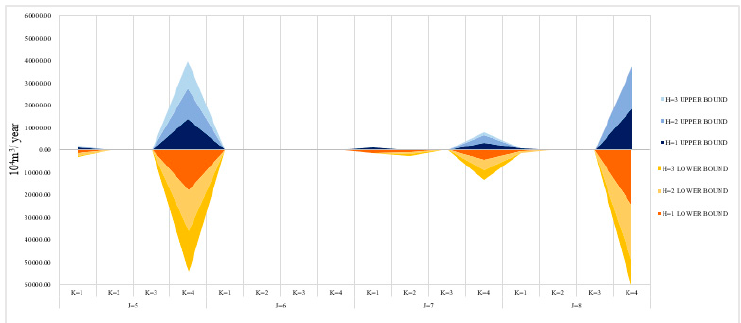
Figure 11. Water shortage in different water use departments in different situations in the first planning period. Water 2020 , 12 , x FOR PEER REVIEW